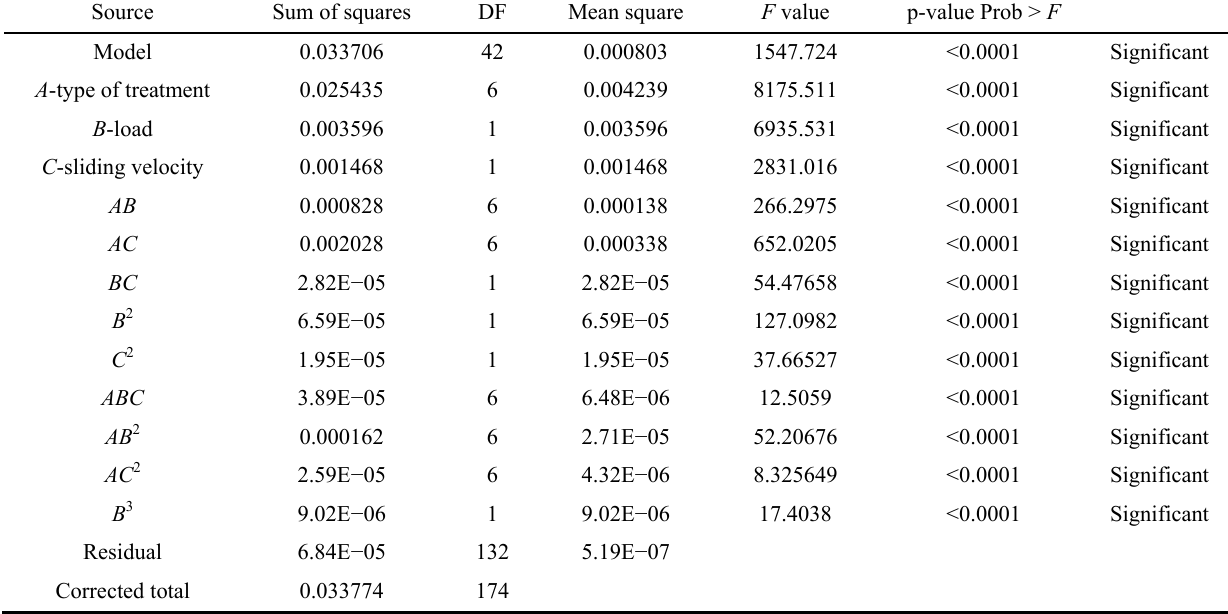
Table 9 Modified ANOVA for the coefficient of friction.